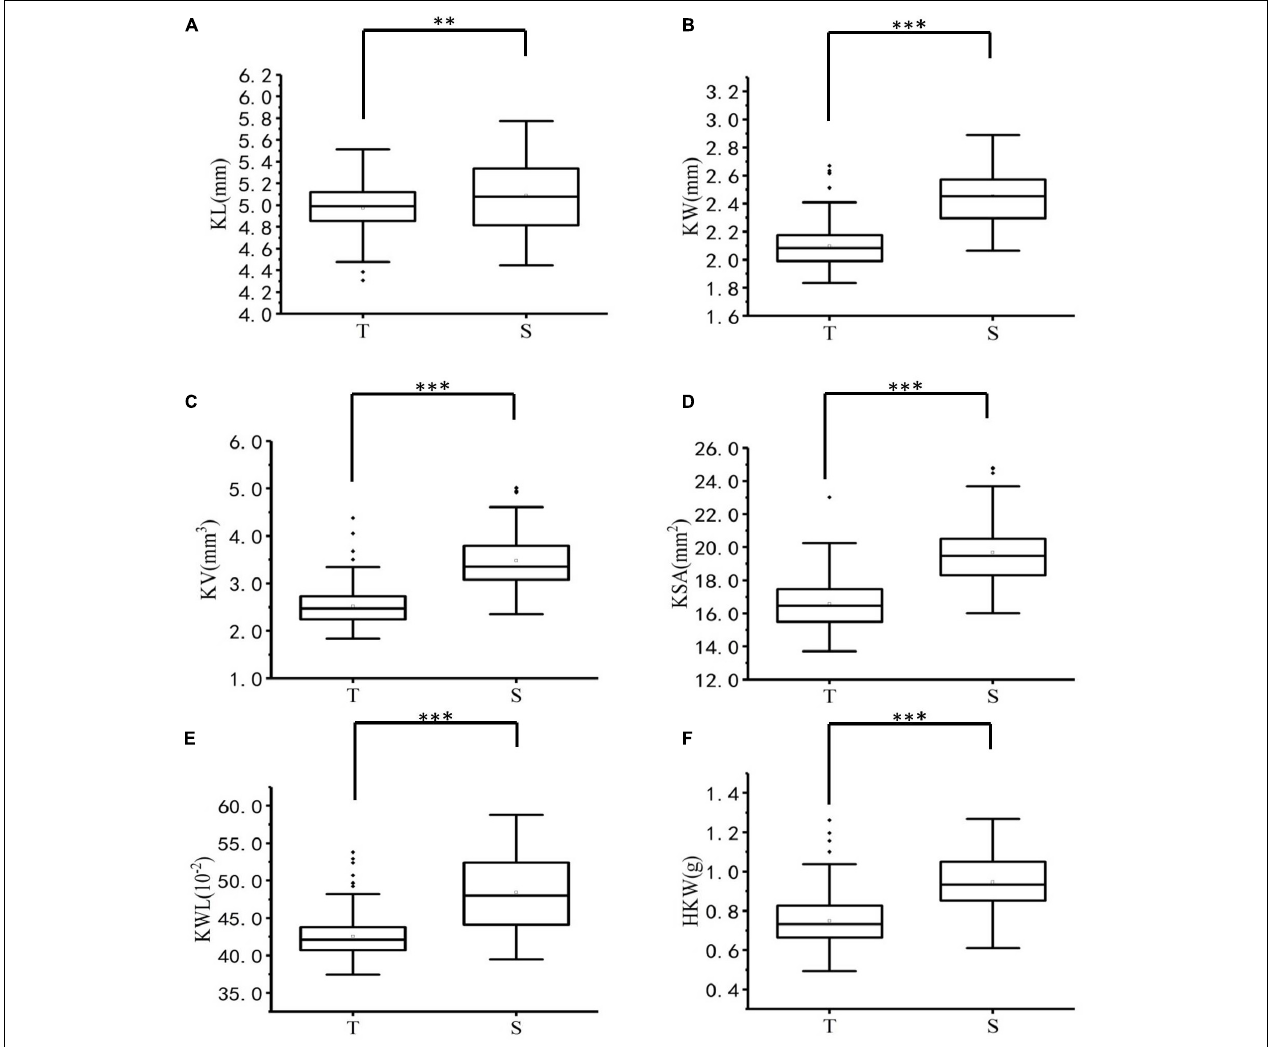
FIGURE 1 | Boxplots of six kernel characters of T-group and S-group. ∗∗ , and ∗∗∗ denote significance at p < 0.01 and p < 0.001, respectively. (A) KL, kernel length (mm), (B) KW, kernel width (mm), (C) KV, kernel volume (mm 3 ), (D) KSA, kernel surface area (mm 2 ), (E) KWL, kernel width to length ratio (%), (F) HKW, hundred-kernel weight